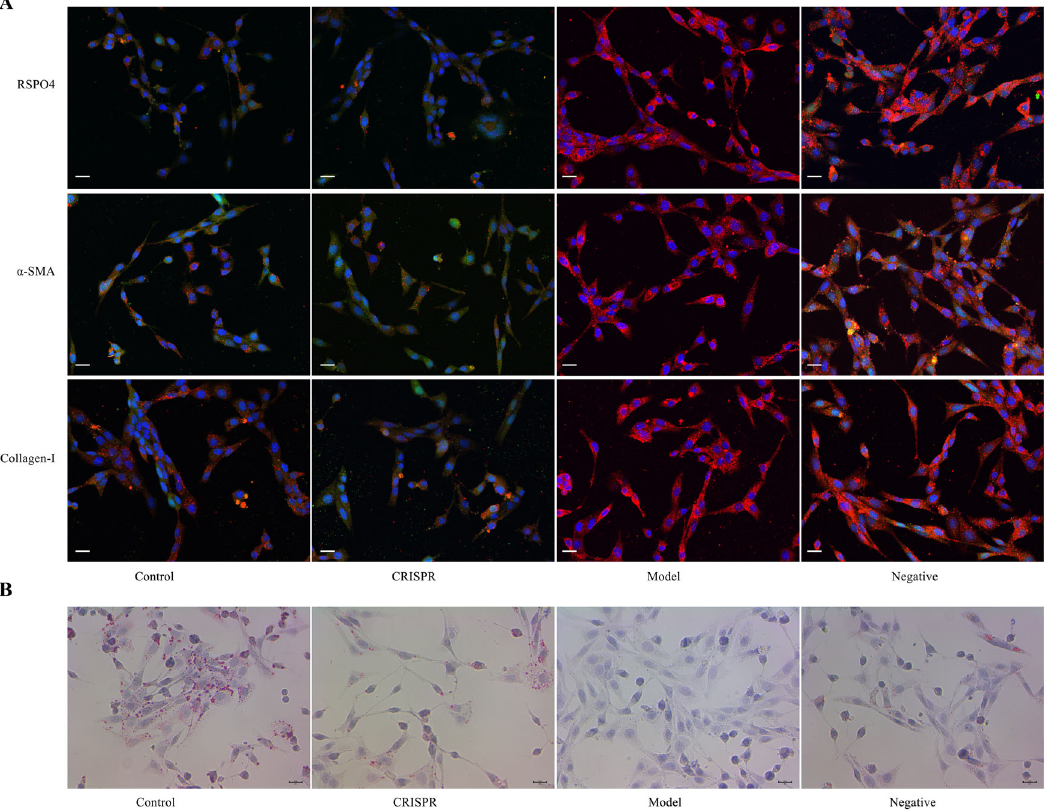
Fig. 2 RSPO4-CRISPR suppresses HSC activation. A The results of immuno fl uorescence assay showed the protein expression of RSPO4, α -SMA, and collagen-I were lower in the CRISPR group than the model group and were close to those of the control (bar 20 μ m, magni fi cation ×400). B . Oil red O staining demonstrated the lipid droplets decreased in the CRISPR group compared with the model group (bar 20 μ m, magni fi cation ×400). HSCs isolated from the CCl 4 -induced fi brotic-liver rats were noted as the model group, cells transfected with RSPO4-CRISPR were noted as the CRISRP group and HSC isolated from normal rats served as the control. Data represent the mean of three independent experiments, and error bars are the standard deviation of means. * p < 0.05 compared with the control, ** p < 0.01 compared with the